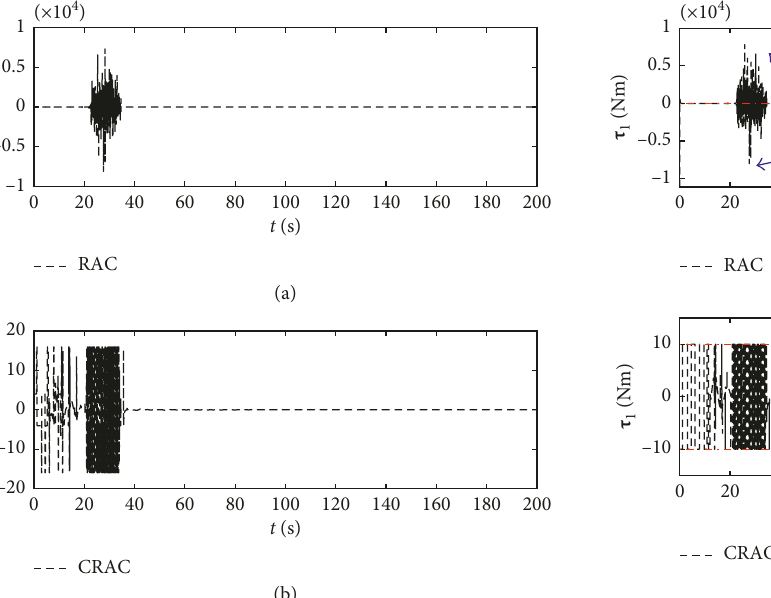
Figure 18: Time response of output torque τ y .